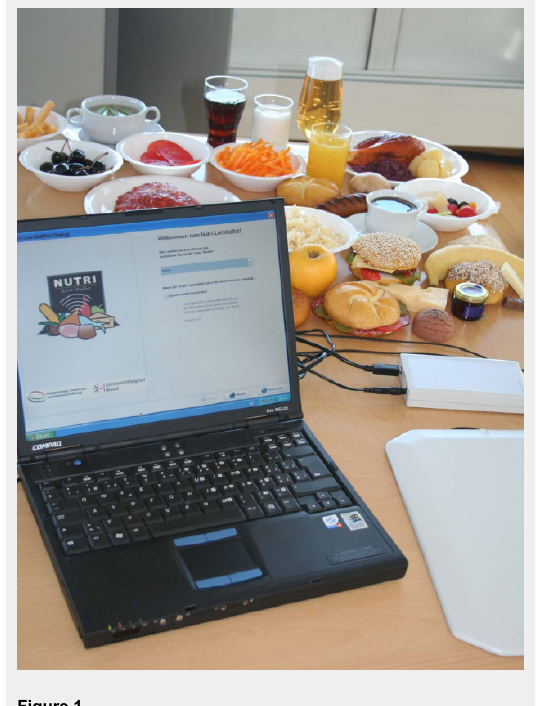
The Nutri-learn buffet with examples of food